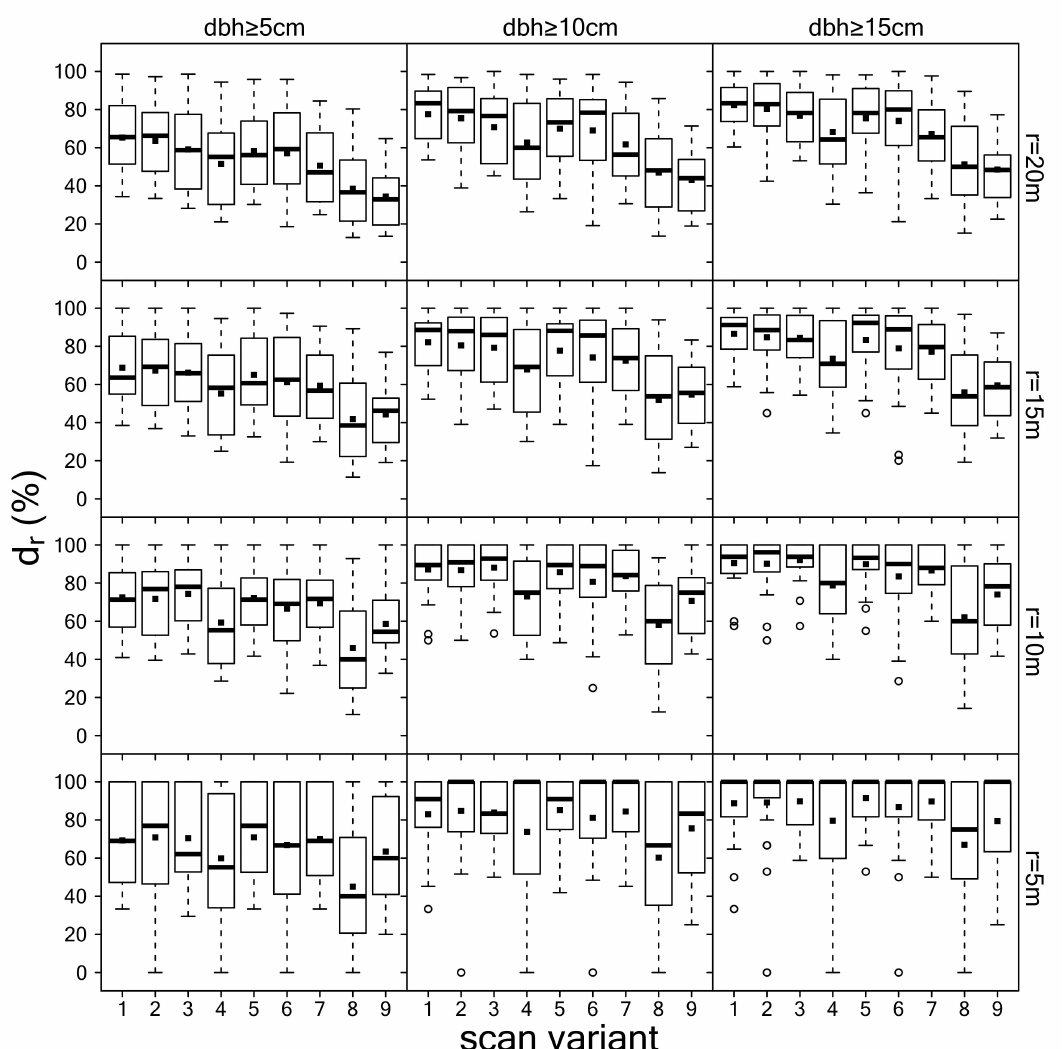
Figure 2. Distribution of detection rates for di ff erent scan variants, lower dbh thresholds, and plot radii. Black squares represent average detection rates over all 23 sample plots and for a specific